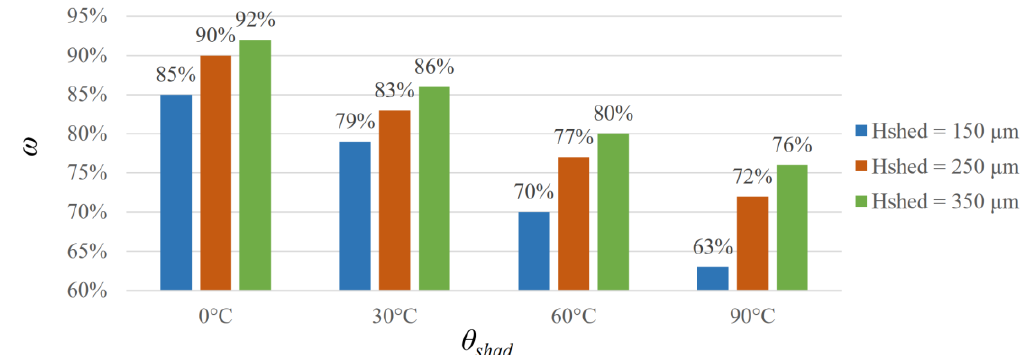
Figure 10. Ratio ( ω ) of vessel energy deposition with shading to that without shading using a superficial vessel.